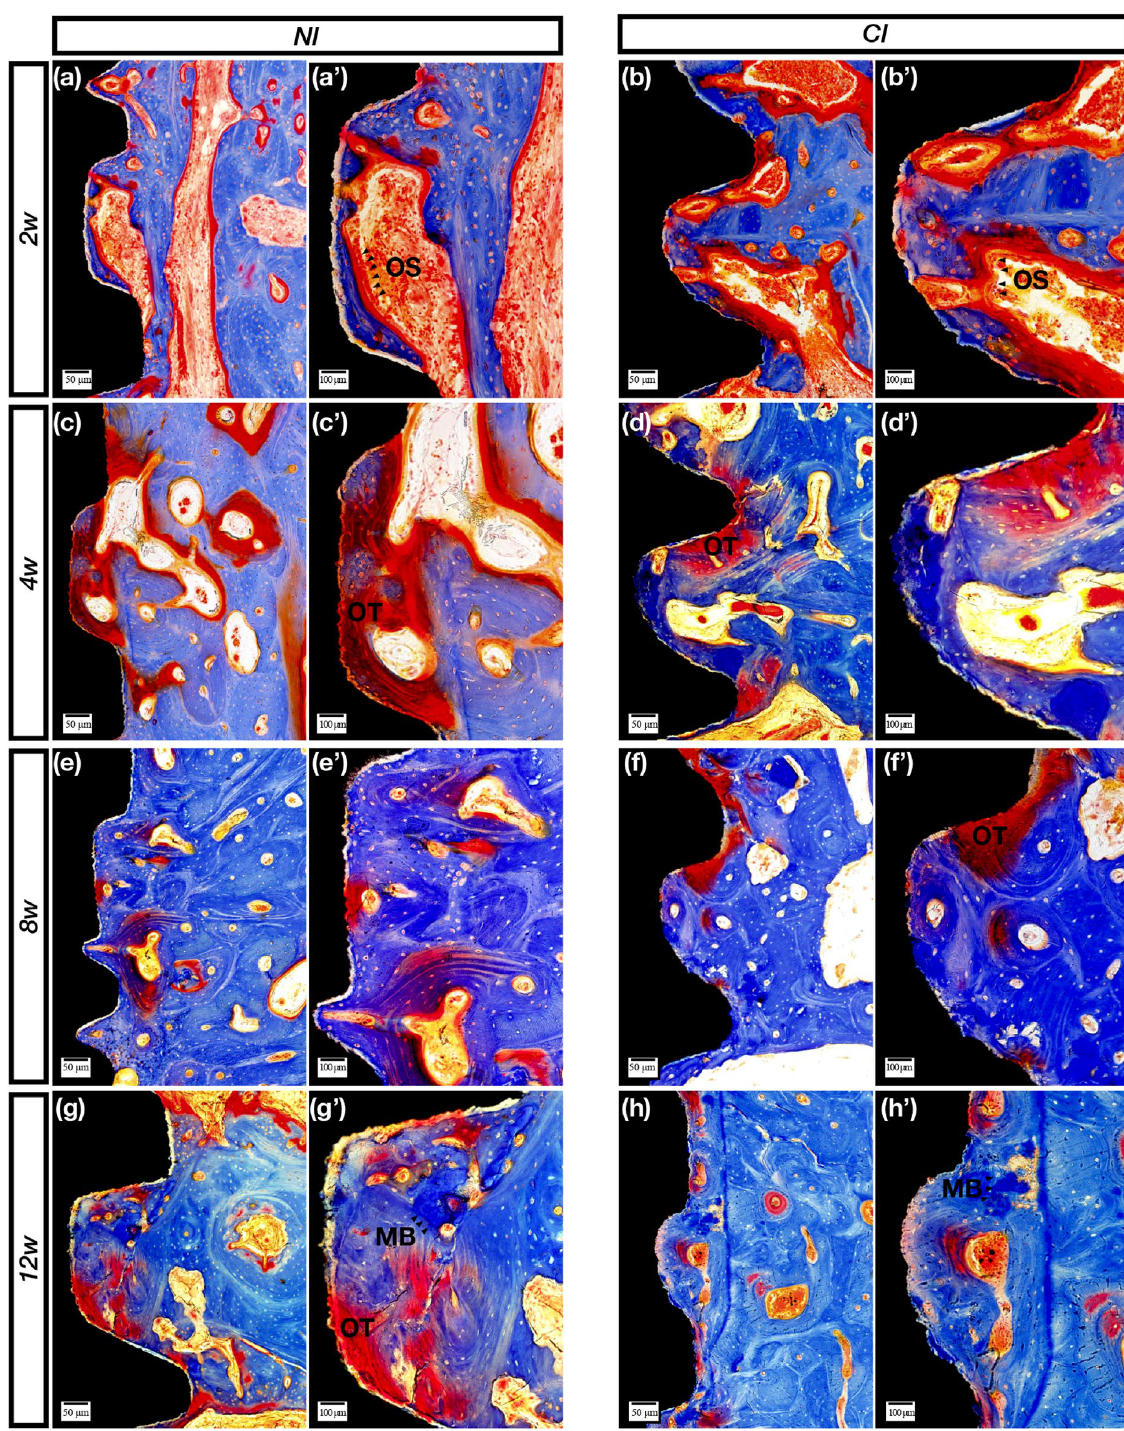
Figure 4. Goldner’s trichrome staining. ( a , a ′ ) Osteoclast (orange-yellow staining)-triggered bone remodeling activities at 2 weeks. ( b , b ′ ) Osteoclast-induced bone resorption appeared mostly on the control implant surface after 2 weeks. ( c , c ′ ) The osteoid (purple-red staining) was full of NI threads. ( d , d ′ ) Osteoid and partial NB were observed at 4 weeks. ( e , e ′ ) In the 8th week, interlaced bone, including the osteoid and NB, was observed. ( f , f ′ ) The boundary between new and old bone became more blurred ( g , g ′ ). Partially mineralized bone (bright blue staining), osteoid and mature bone were shown in the threads of the NIs after 12 weeks. ( h , h ′ ) Mature bone including mineralized regions. OS osteoclasts, OT osteoid, MB mineralized bone. Scale bars represent 50 μm ( a–h ) and 100 μm ( a ′ – h ′ ); original magnification: ( a – h ) × 10, ( a ′ – h ′ ) ×